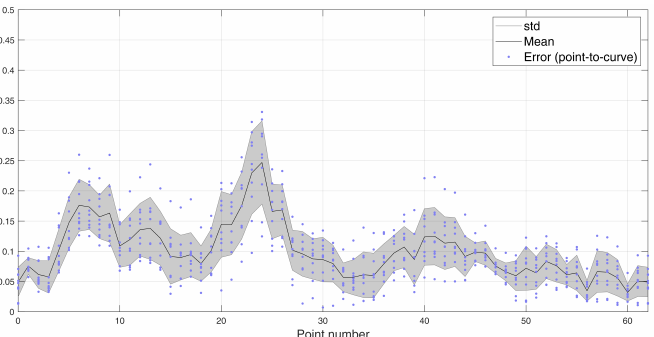
Figure 14. Error (point–to–curve) from the reference masticatory trajectory to the estimated trajectory in 10 iterations of the static positioning test, with the mean and standard